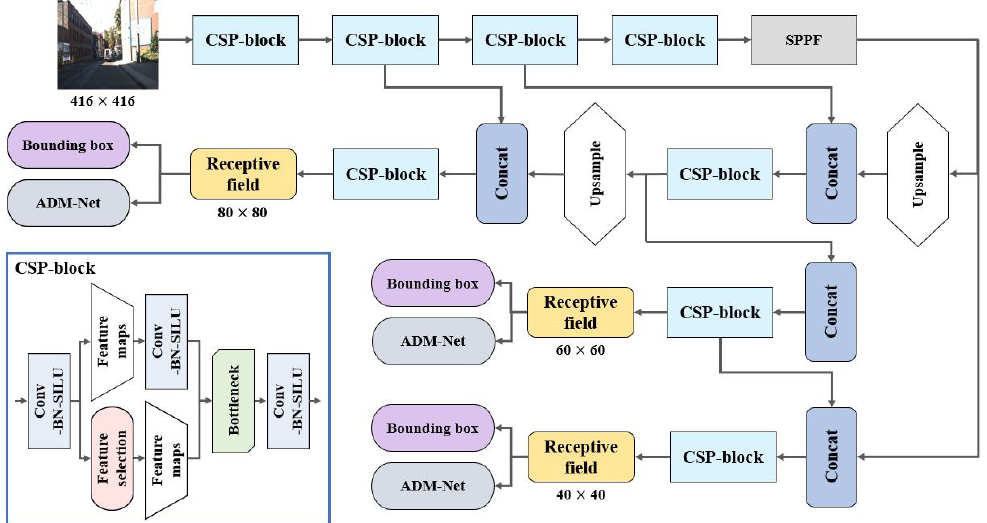
Figure 4. Architecture of the proposed feature-selection-based attentional-deconvolution detec- tor